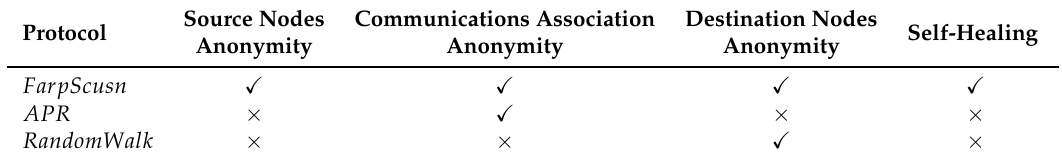
Table 3. Performance